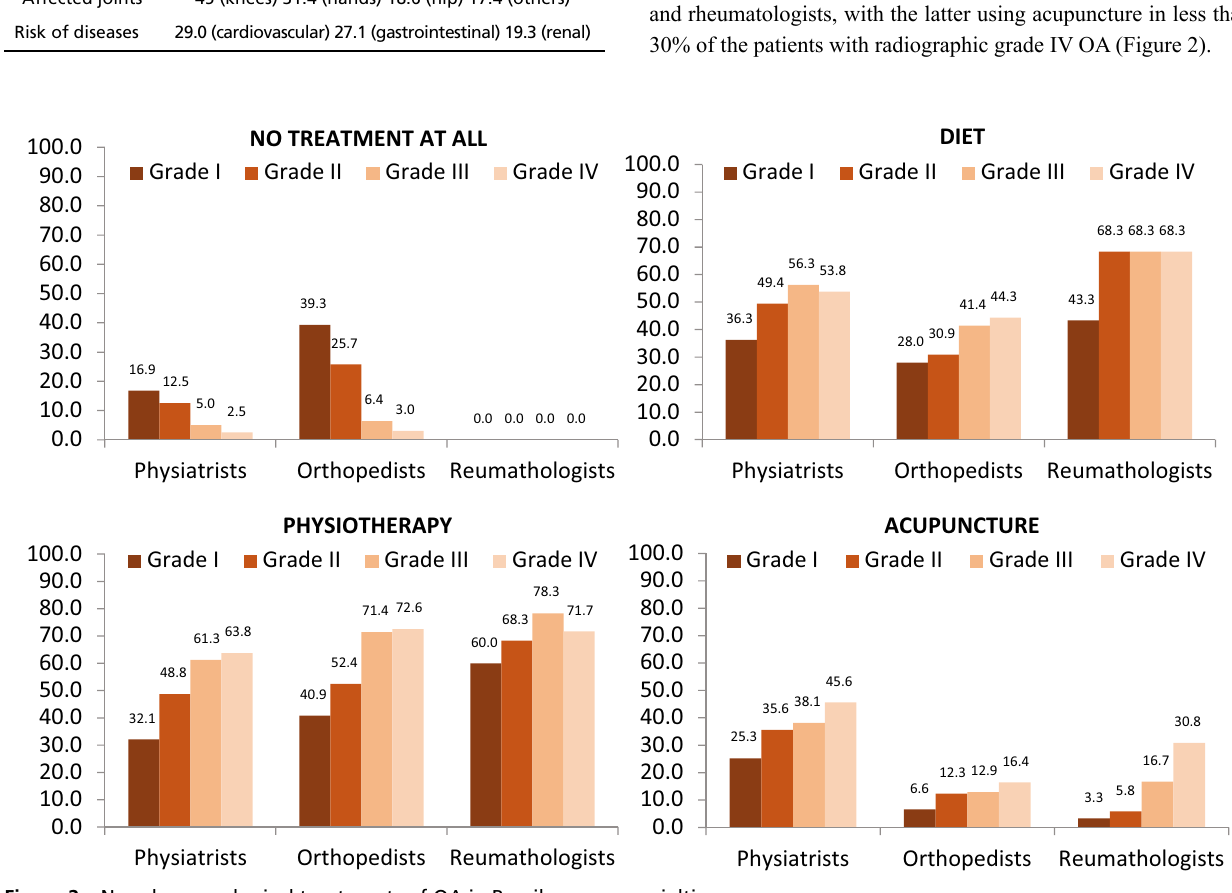
Figure 2 – Nonpharmacological treatments of OA in Brazil among specialties